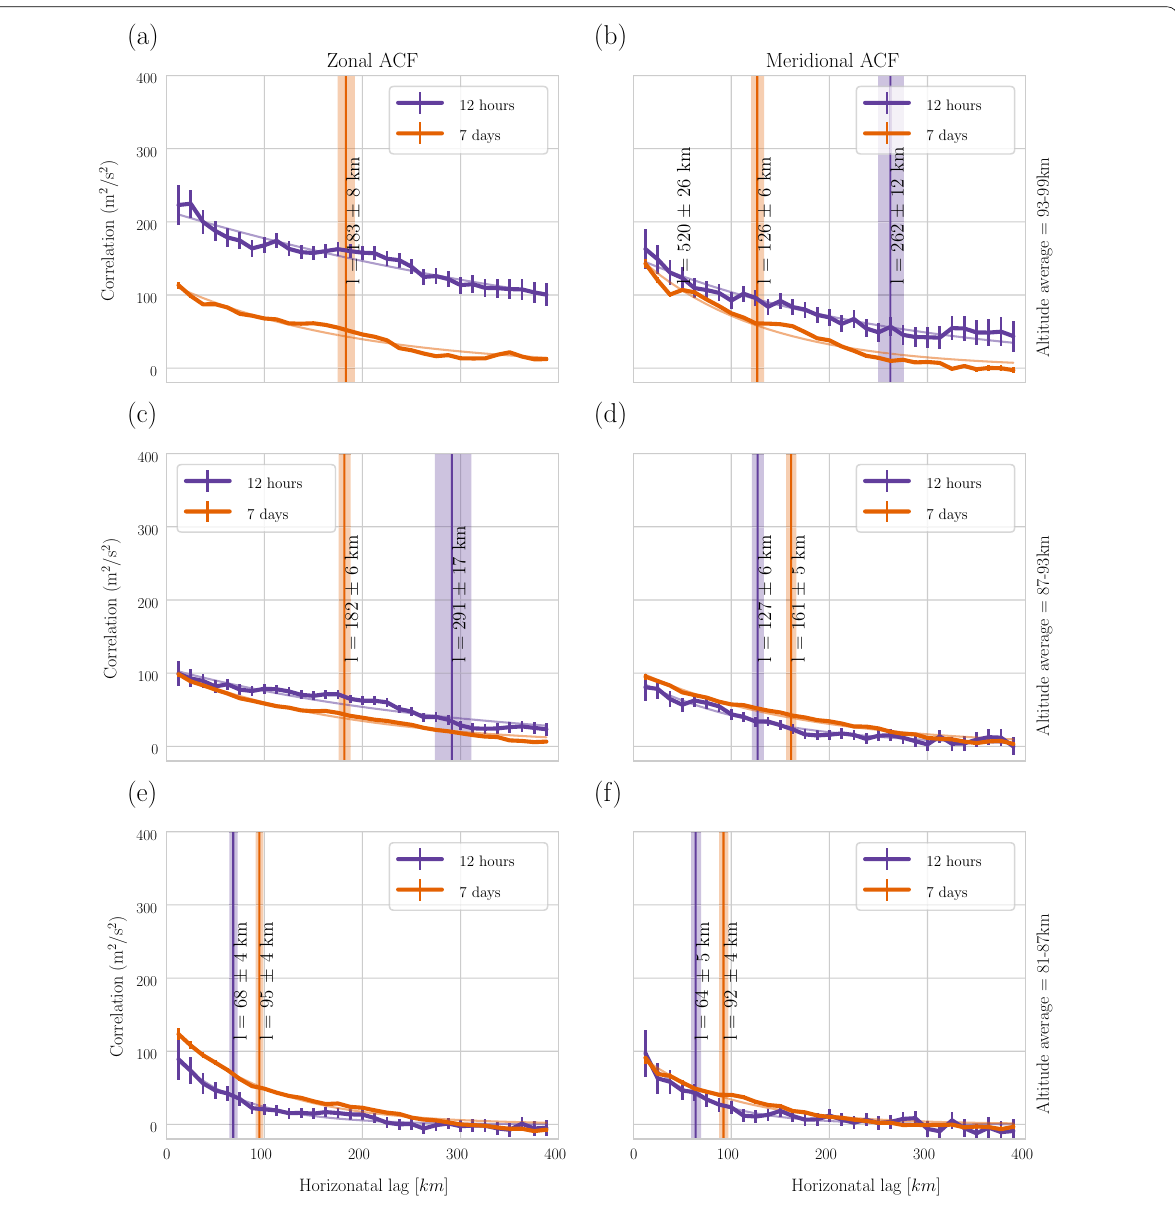
Fig. 8 Orange line in the plots show the horizontal autocorrelation function (ACF) of 4-h high pass filtered zonal and meridional components using WCFI method during 7 days of the campaign. The purple lines show the horizontal ACFs of 4-h high pass filtered zonal and meridional wind components from a 12 h during the campaign. Plots a , c , e show the ACFs of zonal components and plots b , d , f show the meridonal components averaged around 84( 3), 90( 3) and 96( 3) km, respectively. Orange and purple vertical lines in the plots correspond to the e-folding length with ± ± ± their uncertainties of ACFs of 7 days and 12 h,